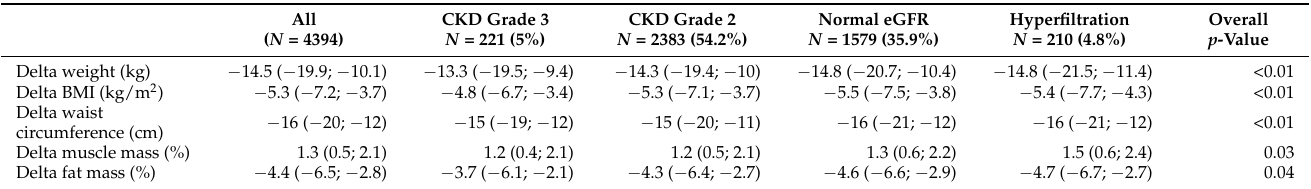
Table 2. Evolution of anthropometric characteristics over time (final measure—initial measure).